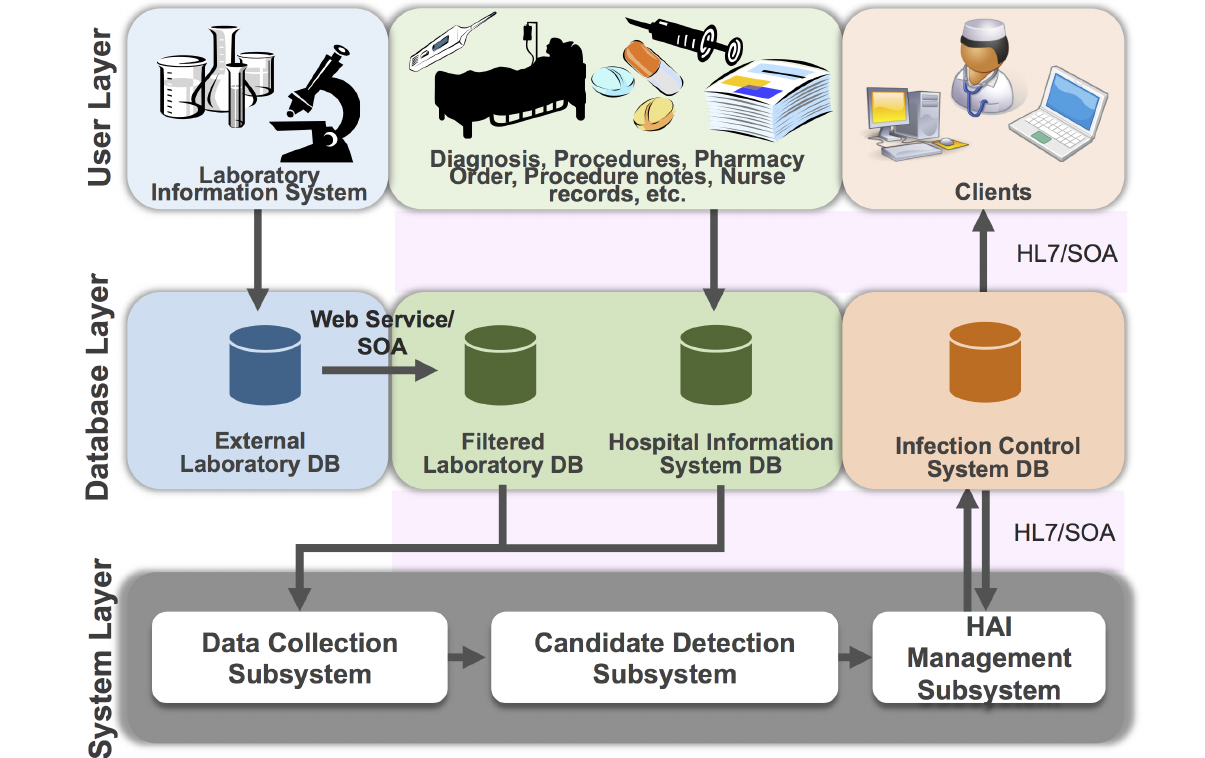
Figure 1. General architecture of the Web-based health care-associated infection (HAI) surveillance and classification system. DB: database; HL7: Health Level Seven; SOA: service-oriented